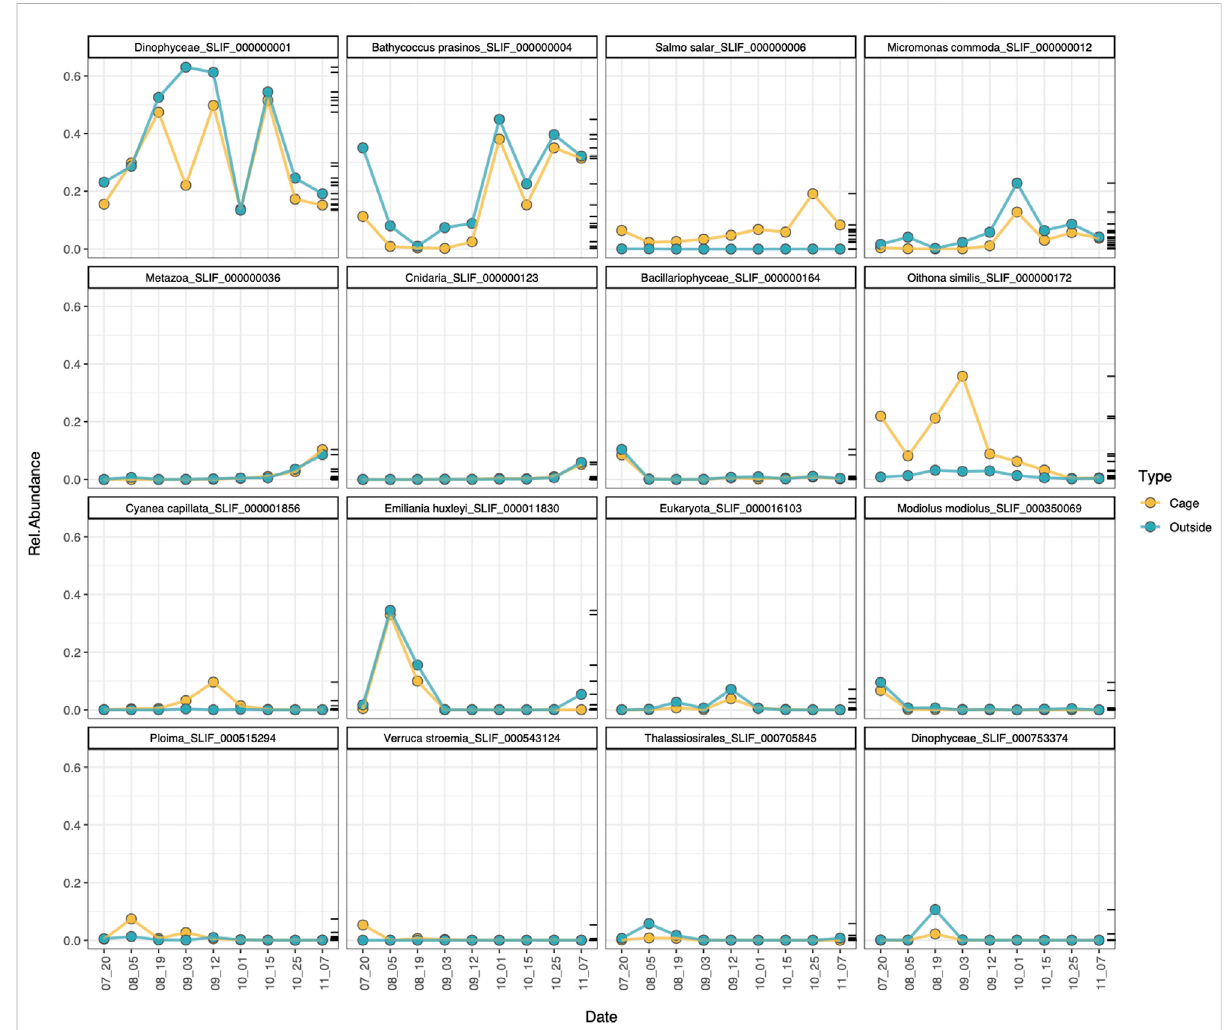
FIGURE 7 Temporal dynamics of the most abundant MOTUs (relab > 1%) in the cage (yellow) and outside (blue)